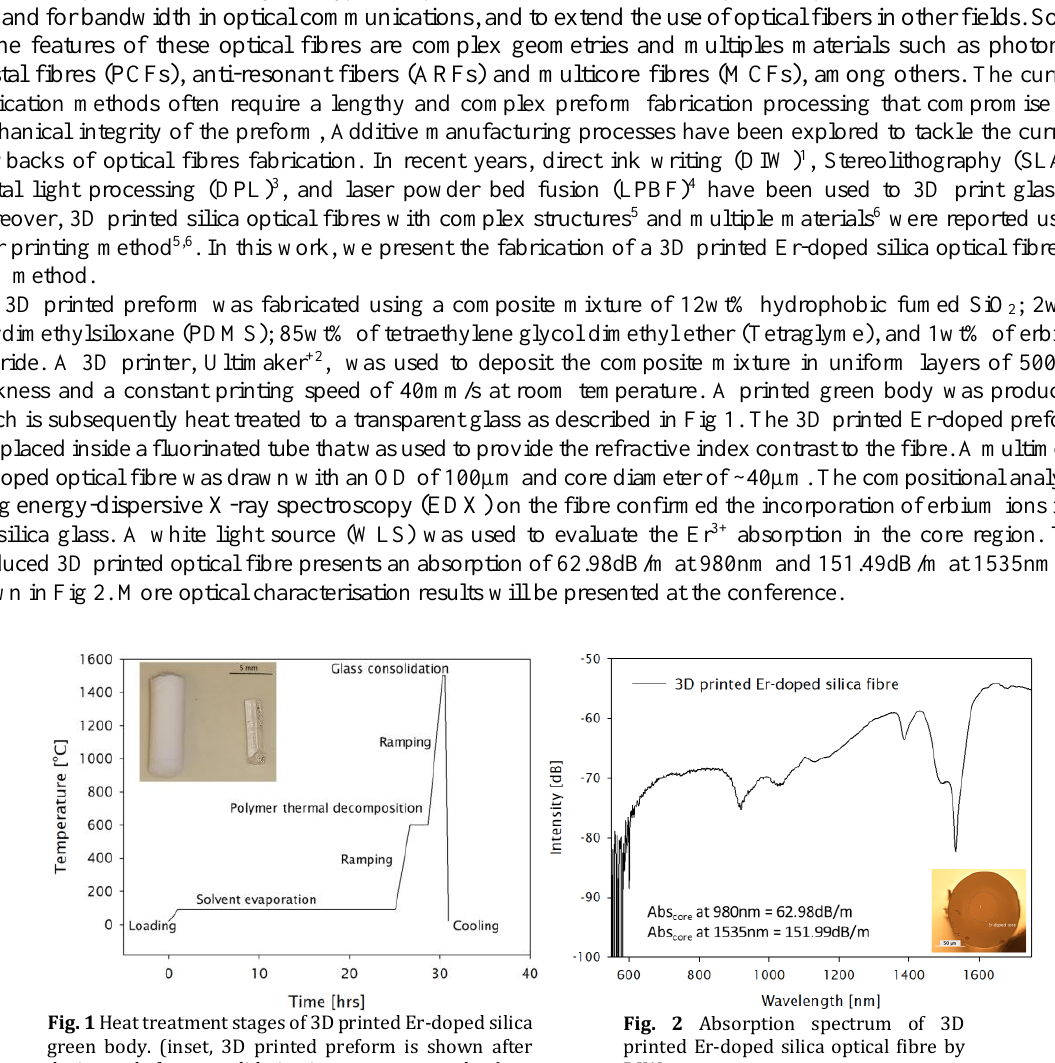
Fig. 1 Heat treatment stages of 3D printed Er-doped silica green body. (inset, 3D printed preform is shown after drying and after consolidation into transparent glass).